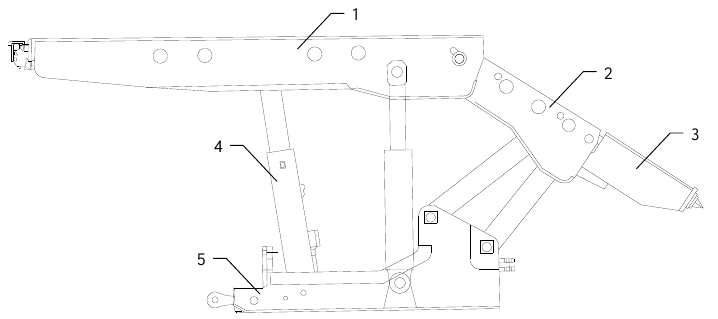
Figure 3. Plane structure of the ZFS5600/16/32 top-coal caving hydraulic support. 1. Top beam; 2. Shield beam; 3. Coal caving organization; 4. Column; 5. Base.